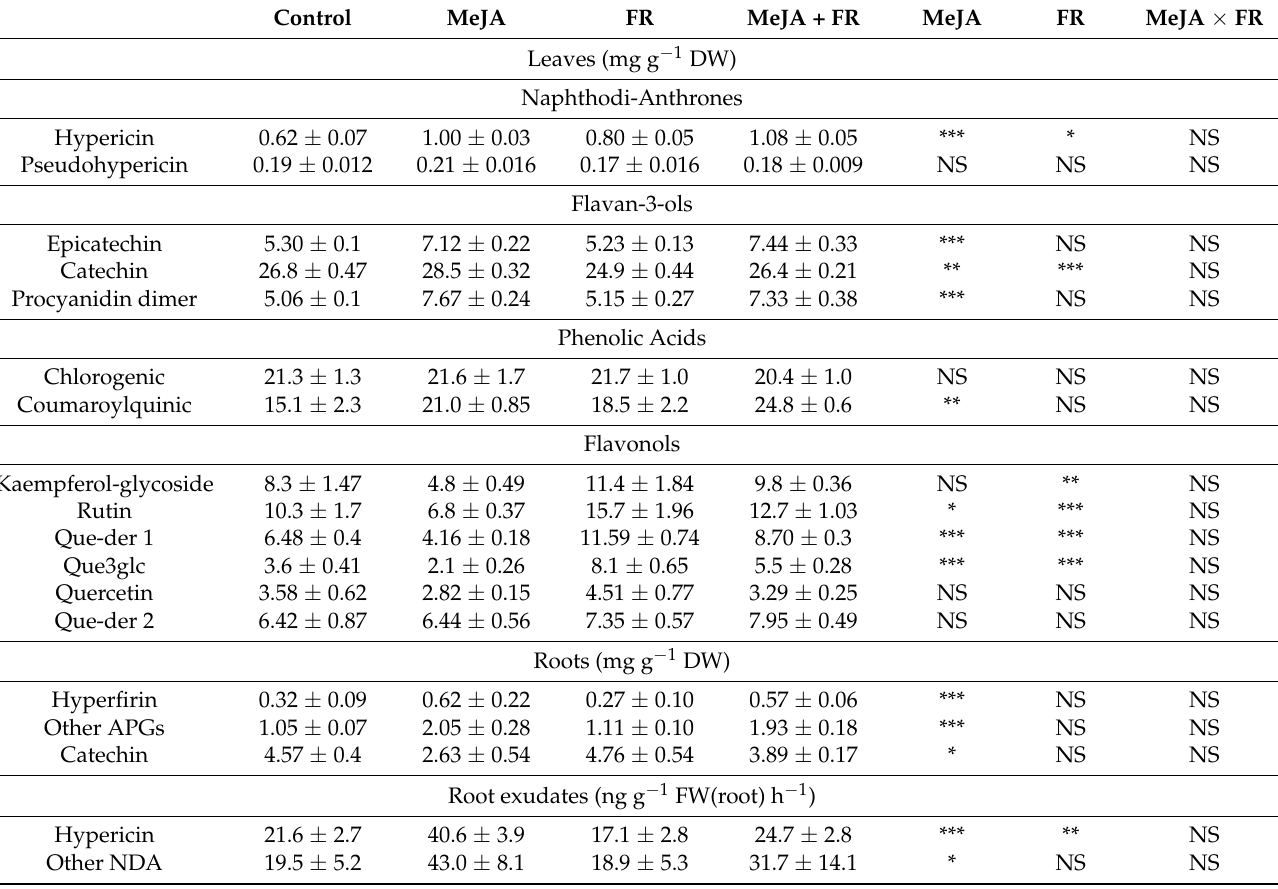
Table 1. The influence of MeJA and FR on leaf and root contents and rates of root exudation of biologically active compounds in Hypericum perforatum cultivated in hydroponic